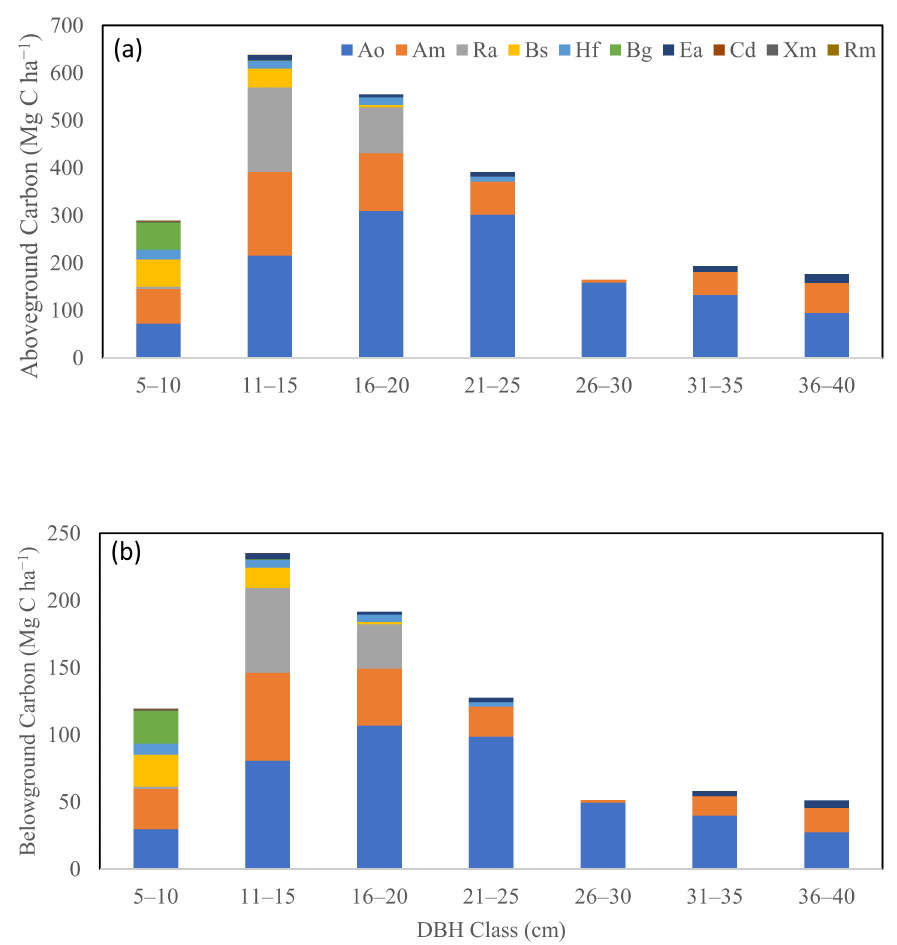
Figure 4. ( a ) Aboveground carbon storage. ( b ) Belowground carbon storage based on the diam- eter class distribution of different mangrove species in the study area. Ao = Avicennia officinalis , Am = Avicennia marina , Ra = Rhizophora apiculata , Bs = Bruguiera sexangula , Hf = Heritiera fomes , Bg = Bruguiera gymnorhiza , Ea = Excoecaria agallocha , Cd = Ceriops decandra , Xm = Xylocarpus moluccen- sis , Rm = Rhizophora mucronata